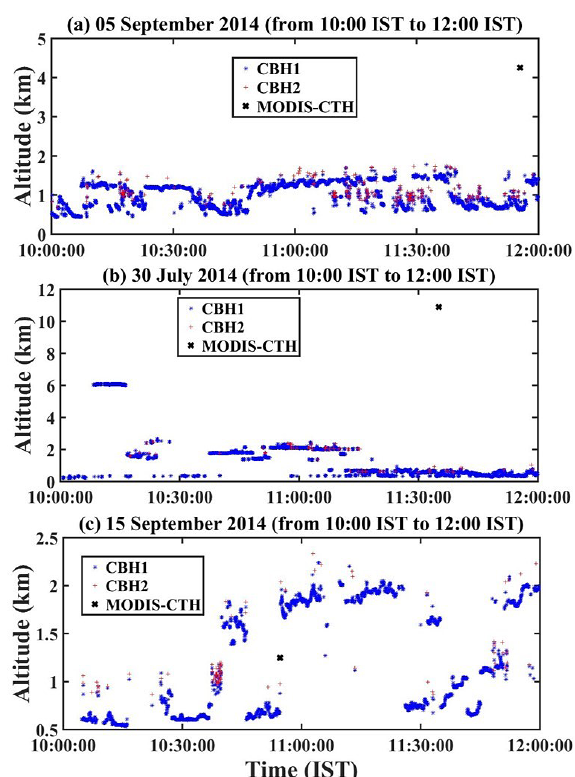
Figure 6. Comparison between cloud top height derived from MODIS, and CBH observed by the ceilometer during the monsoon season over the Ahmedabad region during sample days for (a) nor- mal rain, (b) heavy rain, and (c) no rain